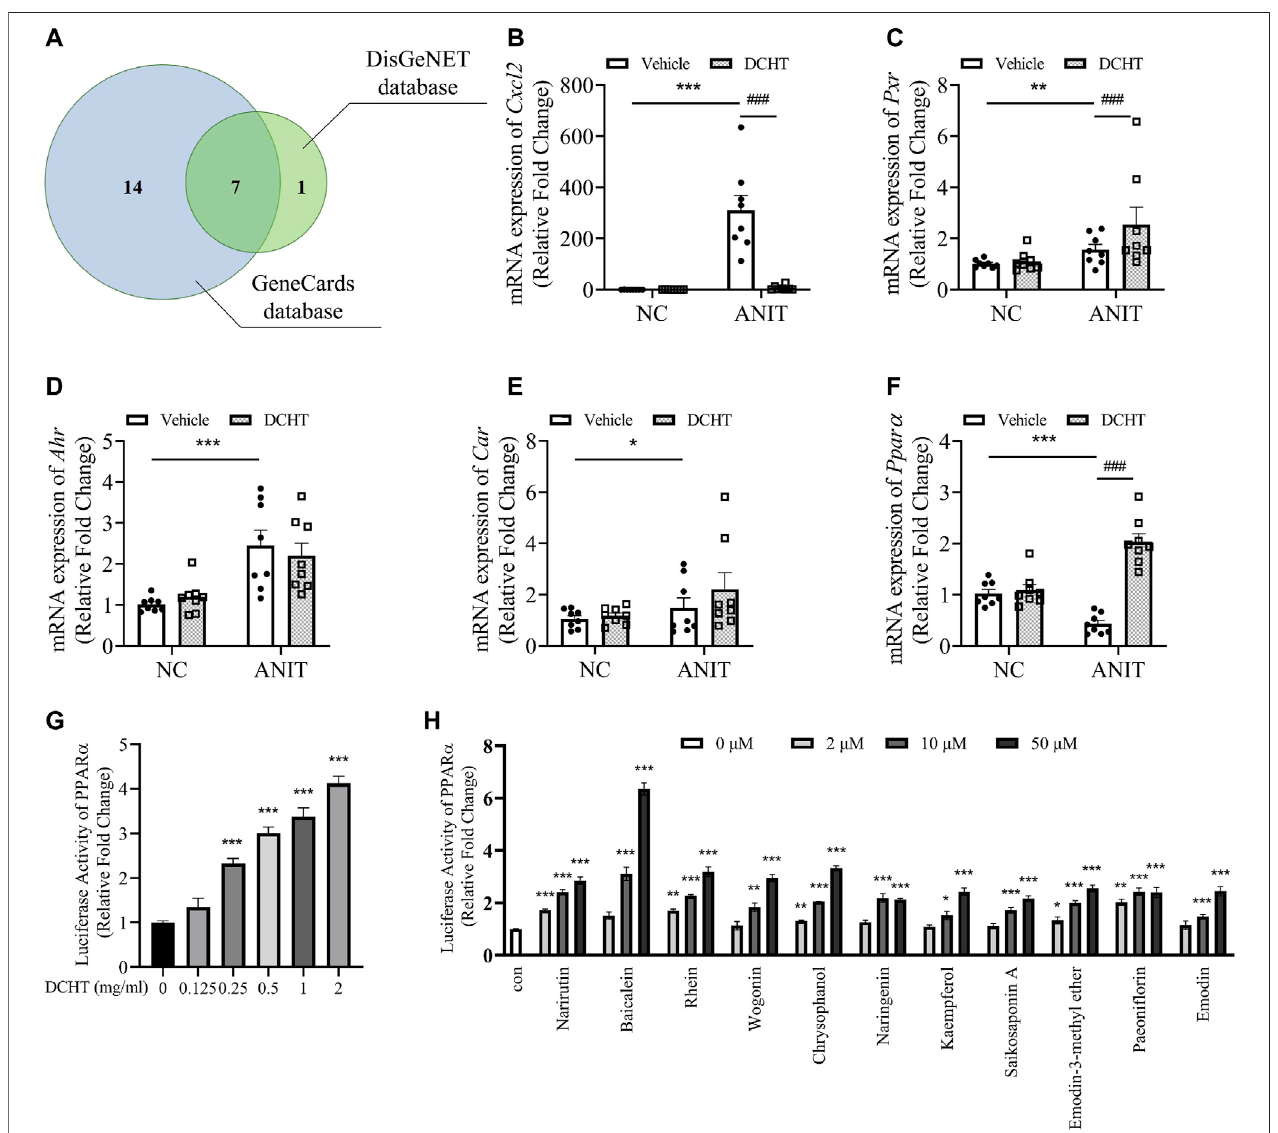
FIGURE 5 | PPAR α is a potential target involved in the DCHT treatment for intrahepatic cholestasis. (A) Venn diagram of 22 putative targets of DCHT acting on intrahepatic cholestasis not extrahepatic cholestasis from Figure 5A . Putative targets in the blue and green circles are from GeneCards database and DisGeNET database, respectively. (B-F) Hepatic mRNA expression of Cxcl2 (B) , Pxr (C) , Ahr (D) , Car (E) and PPARa (F) was measured by RT-qPCR after treatment of mice with ANIT (2 days) and/or DCHT (5 days, 1.875 g/kg), as indicated. Data are shown as means ± SEM.; * p < 0.05, ** p < 0.01, *** p < 0.001 compared with the vehicle group; ### p < 0.001 compared with the ANIT treatment group, n = 8. (G,H) luciferase activity from a PPAR α -driven luciferase reporter was determined after treatment of HEK293T cells with DCHT (0 – 2 mg/ml) (G) or indicated compounds (2 – 50 μ M) (H) for 24 h using dual-luciferase reporter approach. Data are shown as means ±